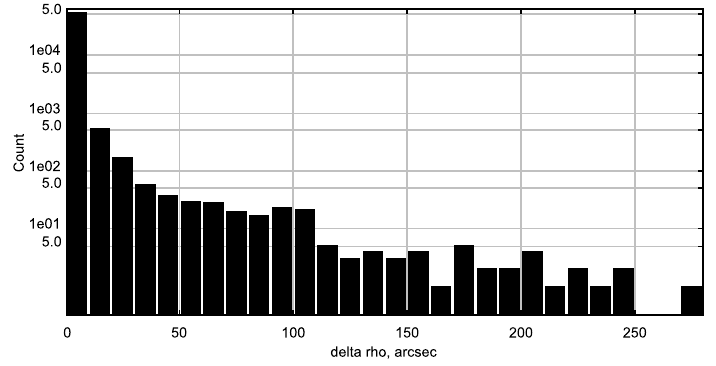
Fig. 3. ∆ (cid:26) histogram for the catalogued